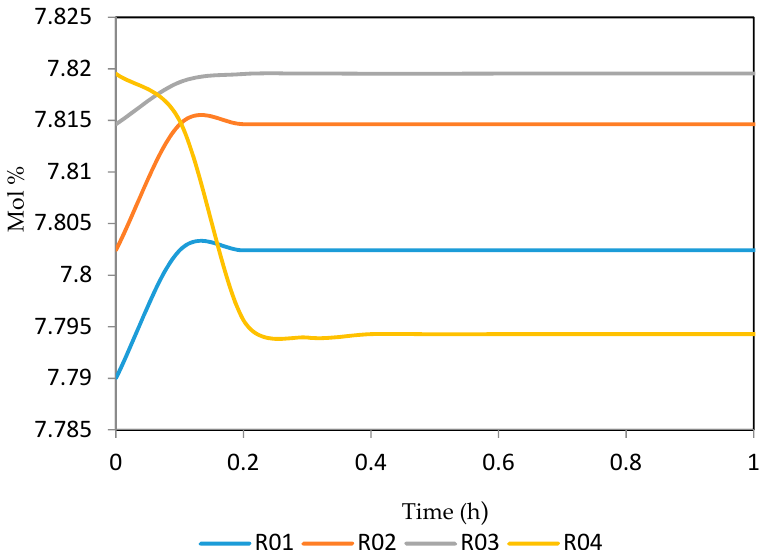
Figure 17. Dynamic behaviour of P 7 in the four